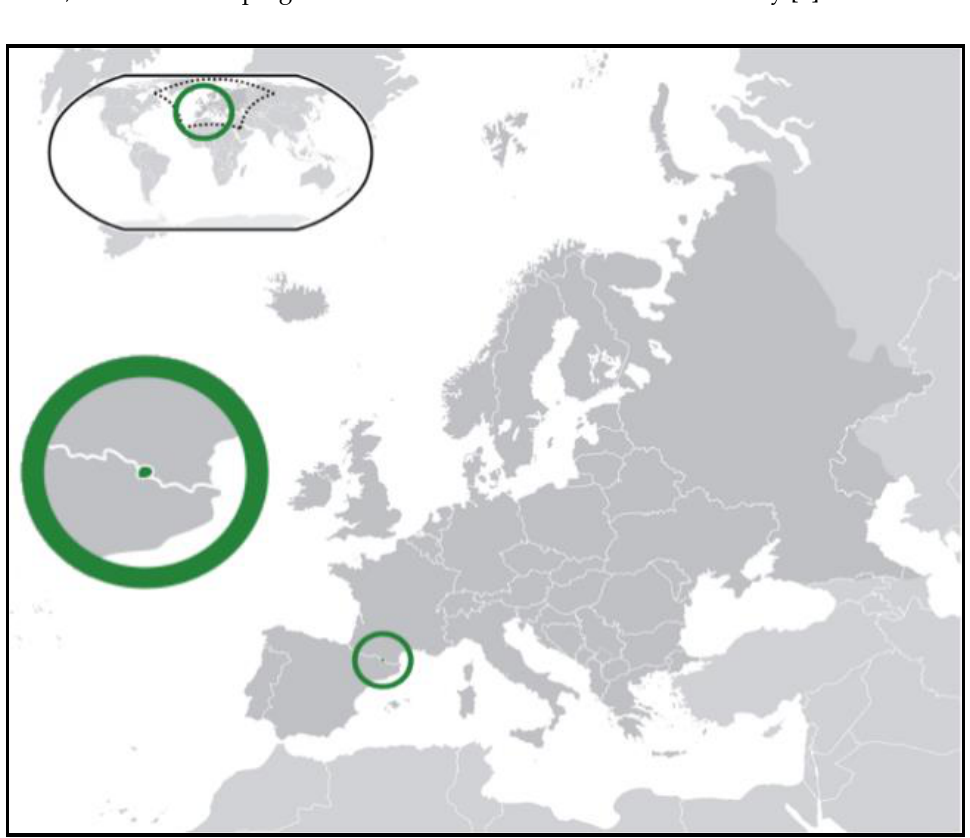
Figure 1. Location of Andorra (green circle) in Europe (dark grey). Source: https://en.wikipe- dia.org/wiki/File:Location_Andorra_Europe.png. (Accessed on 29 September 2020).